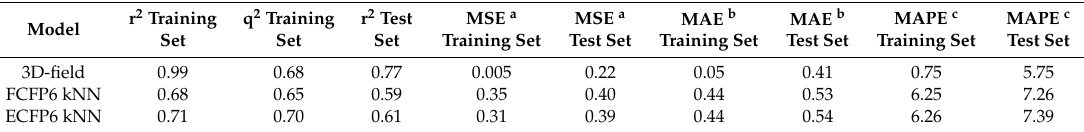
Figure 2. Experimental vs. predicted p K i of the compounds in the training and test set for the different QSAR models. Table 1. Models statistics.